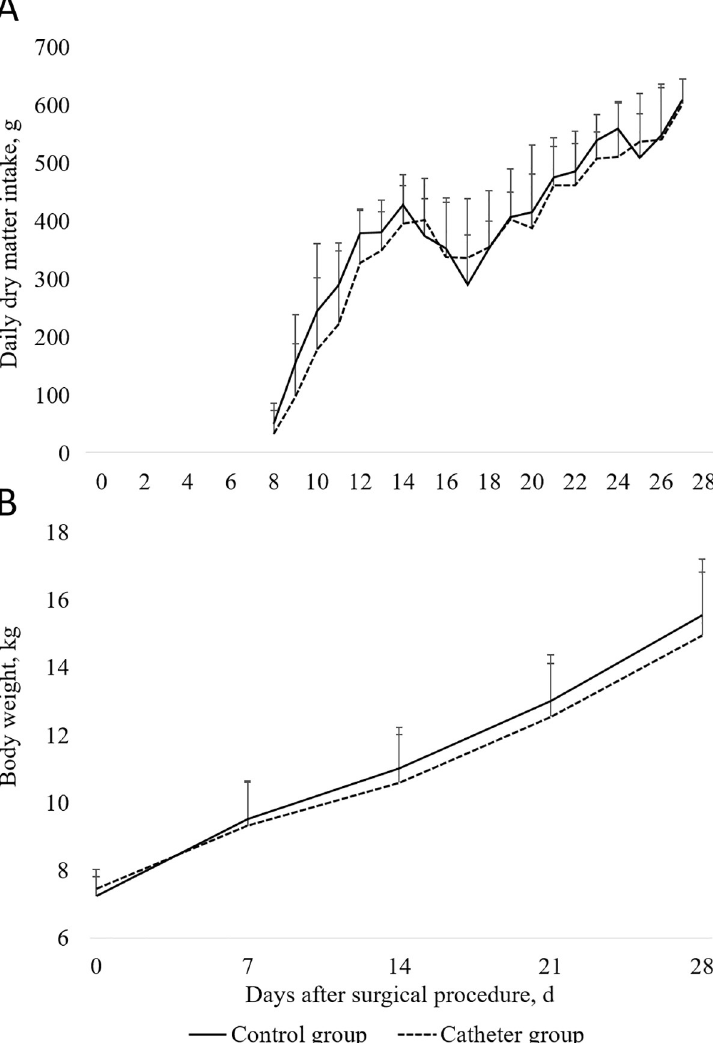
Fig 5. A. Effect of catheter insertion at 21 days of age (d0) on daily dry matter intake of piglets fed ad libitum after weaning. B. Effect of catheter insertion at 21 days of age (d0) on body weight of piglets from d0 to d28 after the surgical procedure. Values shown are means ± SDs. Statistical analysis was performed by ANOVA using the experimental group as a fixed effect and the sow as random effect (MIXED procedure, SAS 9.4, SAS Institute Inc. Cary, NC, USA). Dry matter intake did not significantly differ between the Control group ( n = 7) and the Catheter group ( n = 7) for each day ( P > 0,10). Mean body weight did not significantly differ between the Control group ( n = 7) and the Catheter group ( n = 7) for each day ( P >